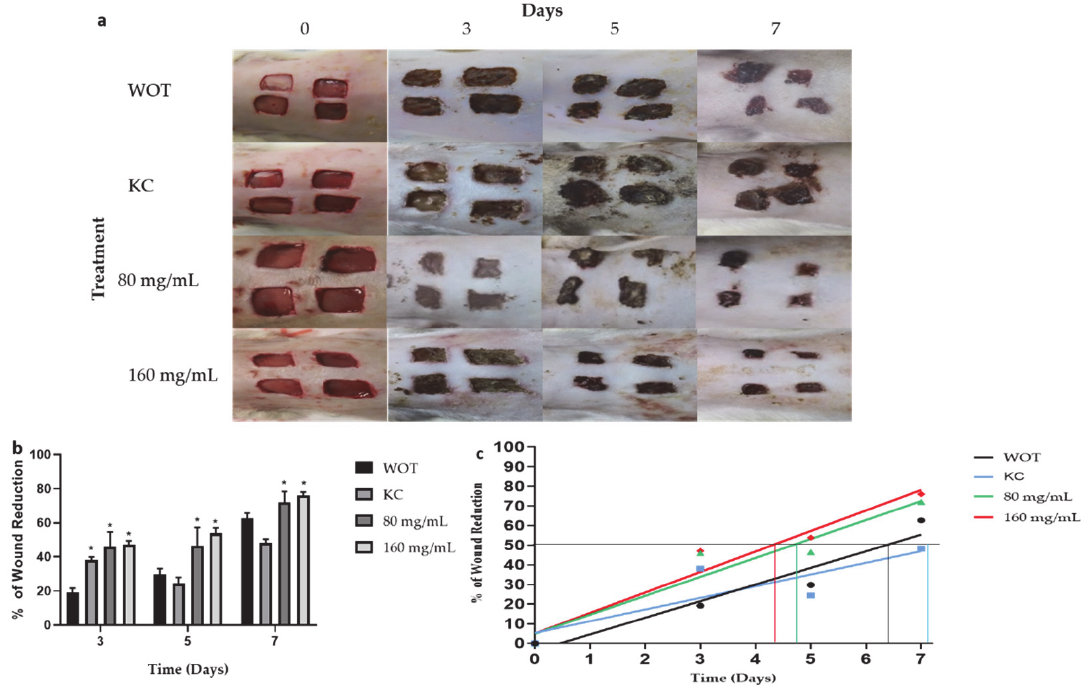
Figure 3. Macroscopic changes induced by PB during wound healing. ( a ) Representative photographs of wounds during 7 days of treatment. WOT, without treatment; KC, Kitoscell; and 80, 160 mg/mL of PB . ( b ) Percentage reduction in wound area with the different treatments. ( c ) Linear regression of % wound reduction in each group, the horizontal line represents the 50% wound reduction, the intersection with the lines of the experimental groups indicates the times required to reach 50% wound reduction. Values are expressed as mean ± SEM of 6 animals per group; * p < 0.05 vs. WOT as indicated by analysis of variance (ANOVA) and Tukey ʹ s post hoc test.